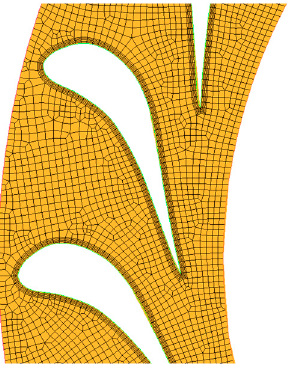
Figure 3. Two ‐ dimensional model of stator blade.